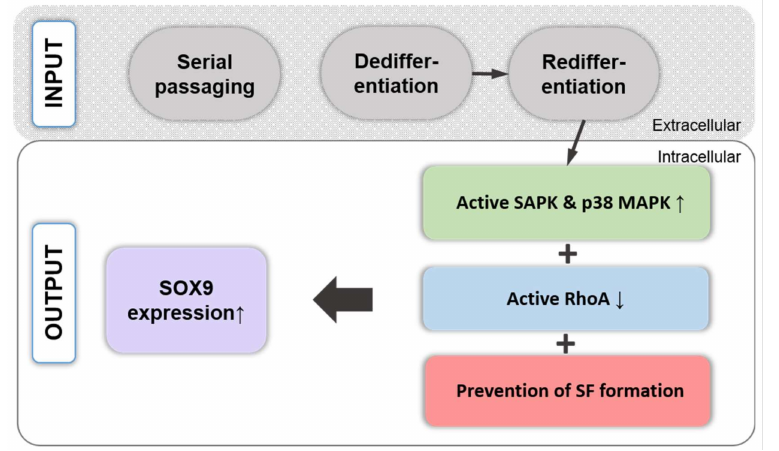
Figure 2. Correlation between actin polymerization, dedifferentiation, and redifferentiation. Redif- ferentiation of dedifferentiated CHs induced by serial passaging depends on active SAPK and p38 MAPK, low active RhoA, and prevention of SFs, resulting in increased SOX9 expression. The up and down arrows indicate an increase or